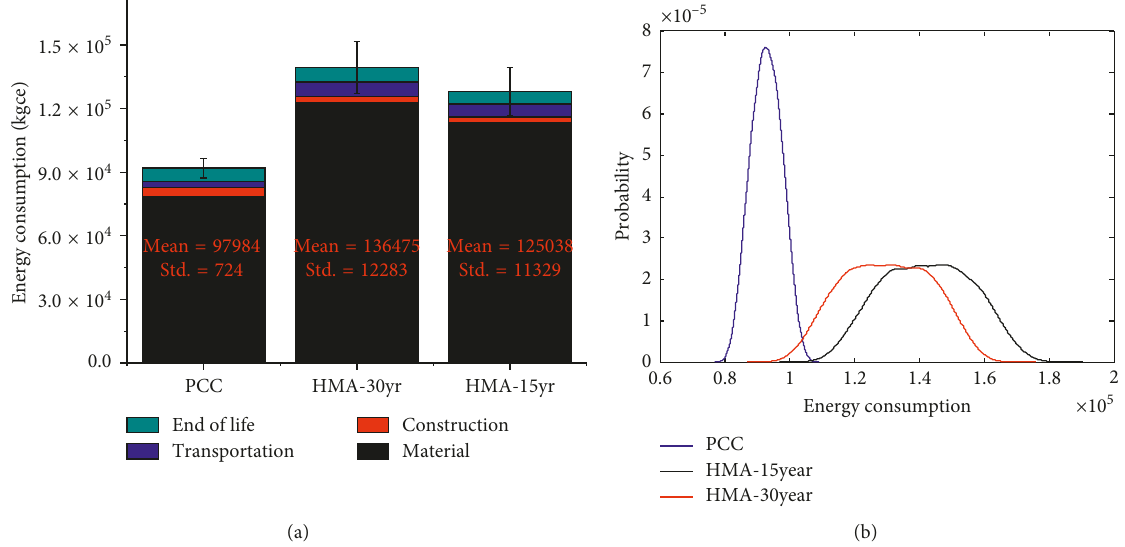
Figure 3: Energy consumption comparisons of the three pavement structures.